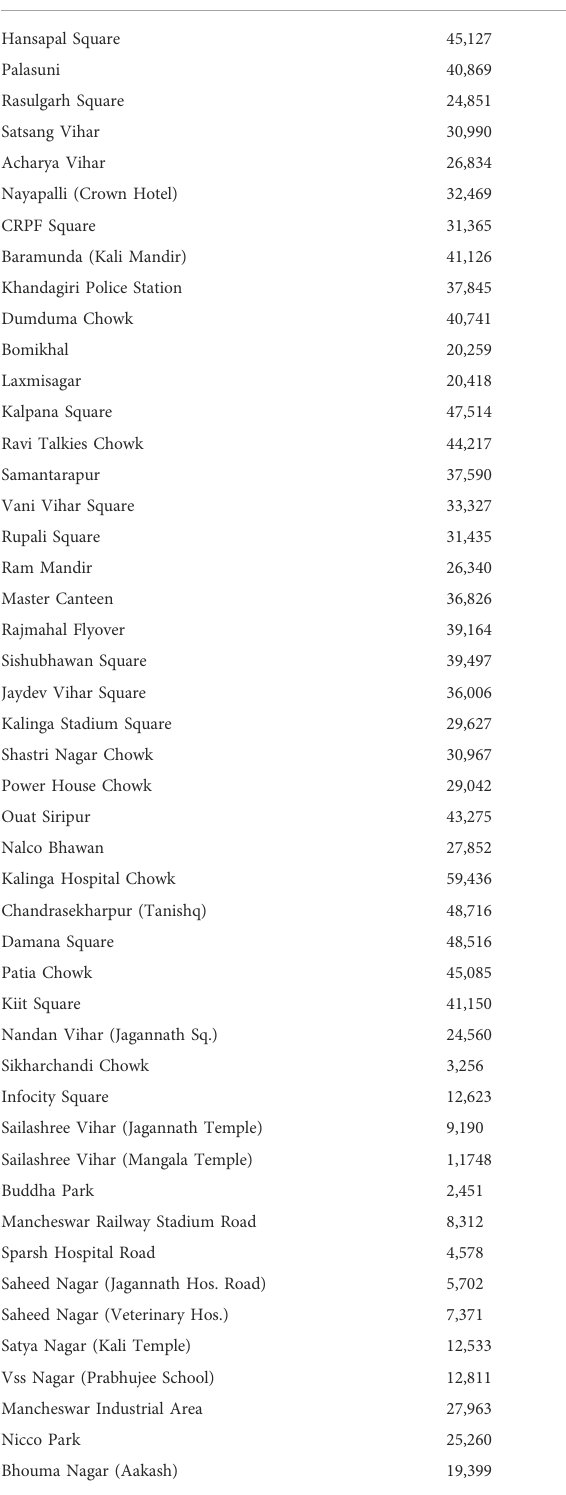
TABLE 4Roads surveyed and totalvehicles inBhubaneswar (including major, minor, national, and state highways) for the year 2018.